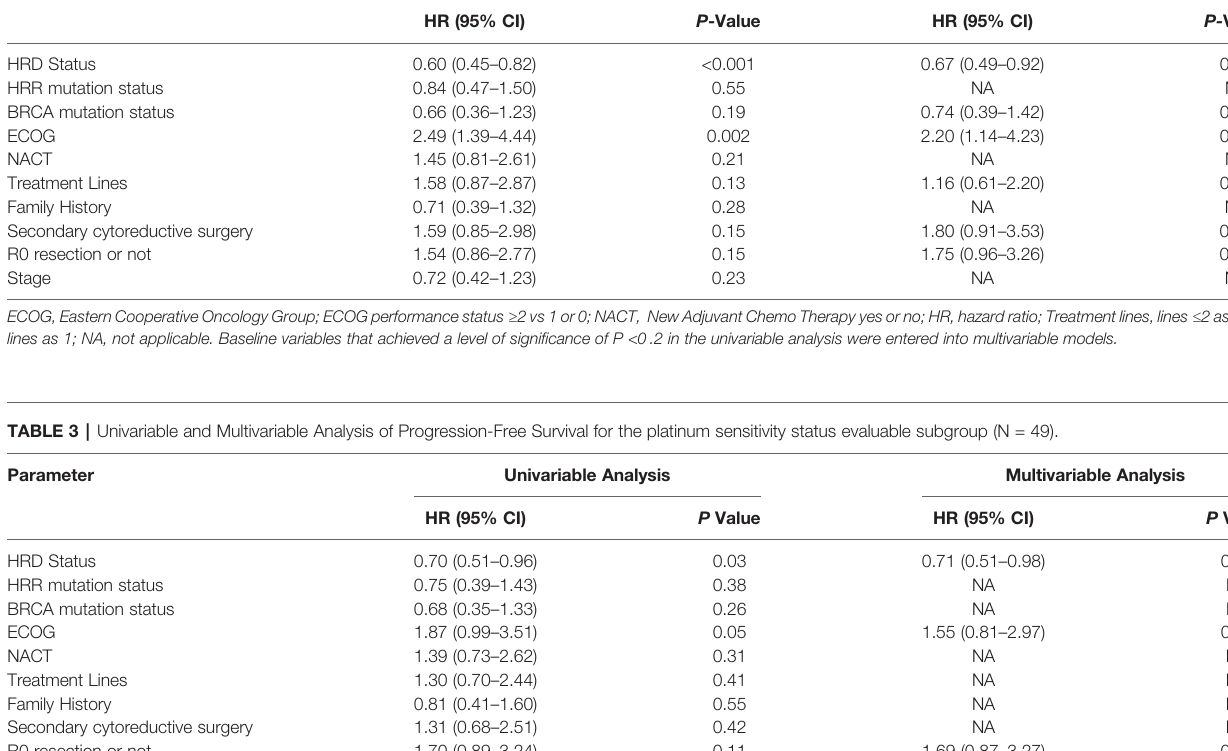
TABLE 2 | Univariable and Multivariable Analysis of Progression-Free Survival for the total 67 patient cohort (N = 67). Parameter